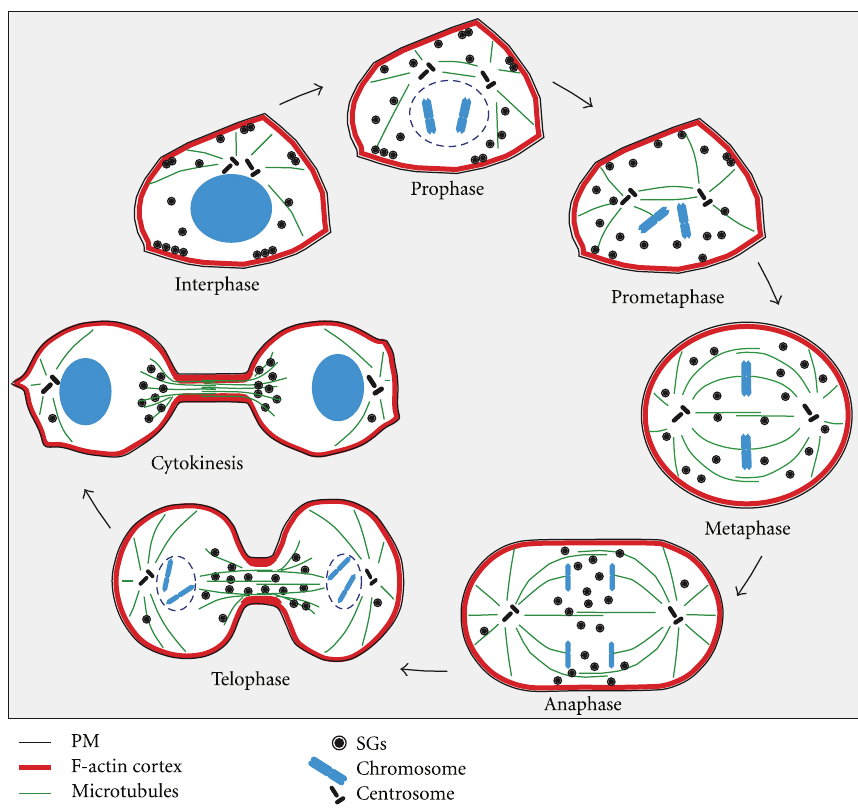
Figure 11: Model of SG partitioning during division of PC12 cells. The scheme summarizes the observed redistribution of SGs during cell